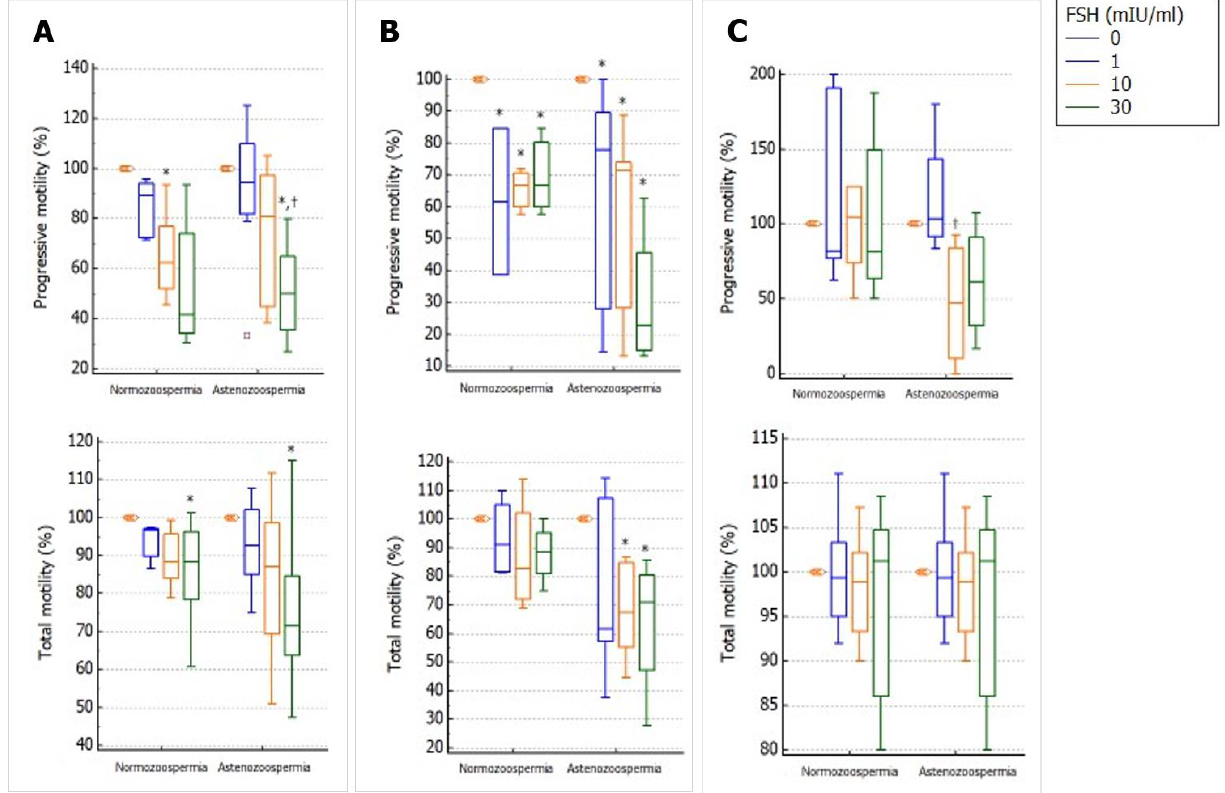
Figure 4. Effects of increasing concentrations of follicle-stimulating hormone (FSH) on in-toto semen sample ( A ), semen pellet ( B ), and spermatozoa recovered by swim-up ( C ) from normozoospermic men and asthenozoospermic patients. Data are reported as the percentage change from the control (FSH 0 mIU/mL), using boxplots. The line inside the box indicates the median, the end of the box the interquartile range, and the values outside the box show the minimum and maximum values. The different colors indicate the different doses of FSH used for sample incubation. * p < 0.05 vs. 0 mIU/mL; † p < 0.05 vs. 1 mIU/mL.